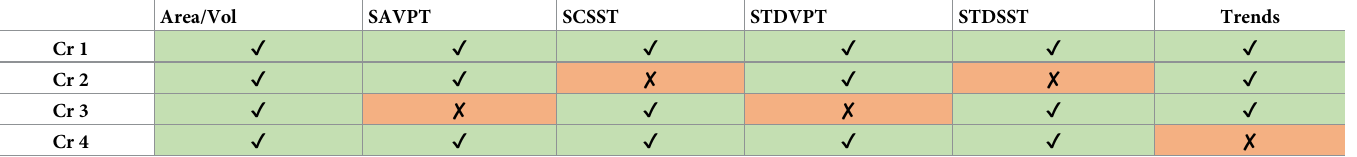
Table 1. Definition of the diagnostics considered in each selection criterion: Area/Volume; Seasonal Average Vertical Profile Temperature (SAVPT); Seasonal Cycle of the Sea Surface Temperature (SCSST); Vertical profile of interannual std (STDVPT); Interannual std of the Sea Surface Temperature (STDSST) and long term Trends in the present climate. Area/Vol STDSST